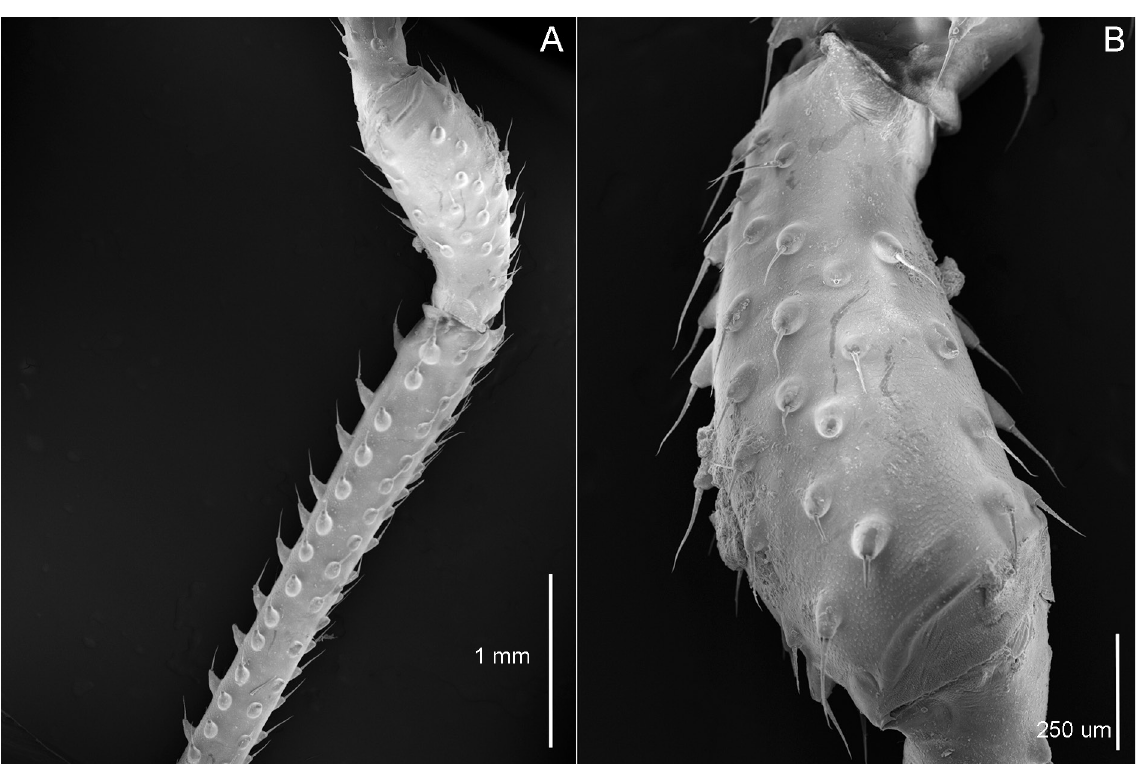
Fig. 6. Troglostygnopsis kalebi sp. nov., ♂, holotype (CNAN-T0850). A . Apical femur, patella and basal tibia IV. B . Patella IV.